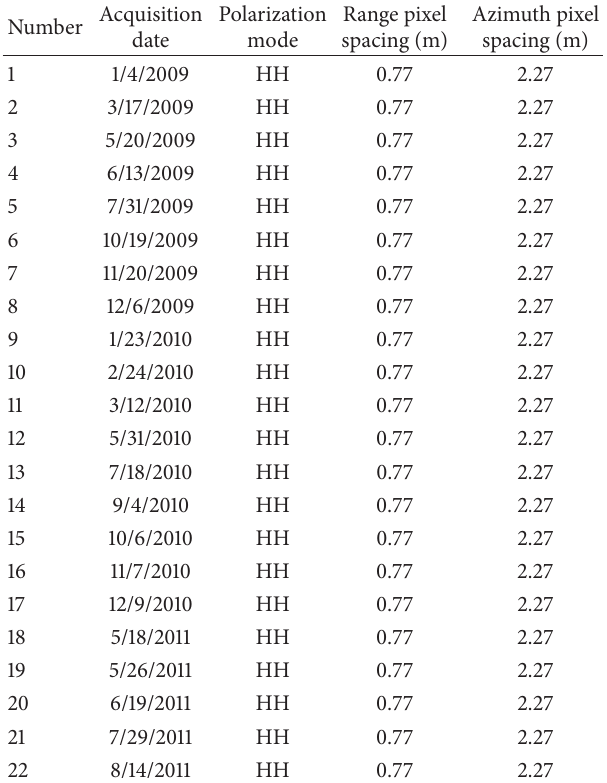
Table 2: Detailed parameters of the COSMO-SkyMed data used in this paper.